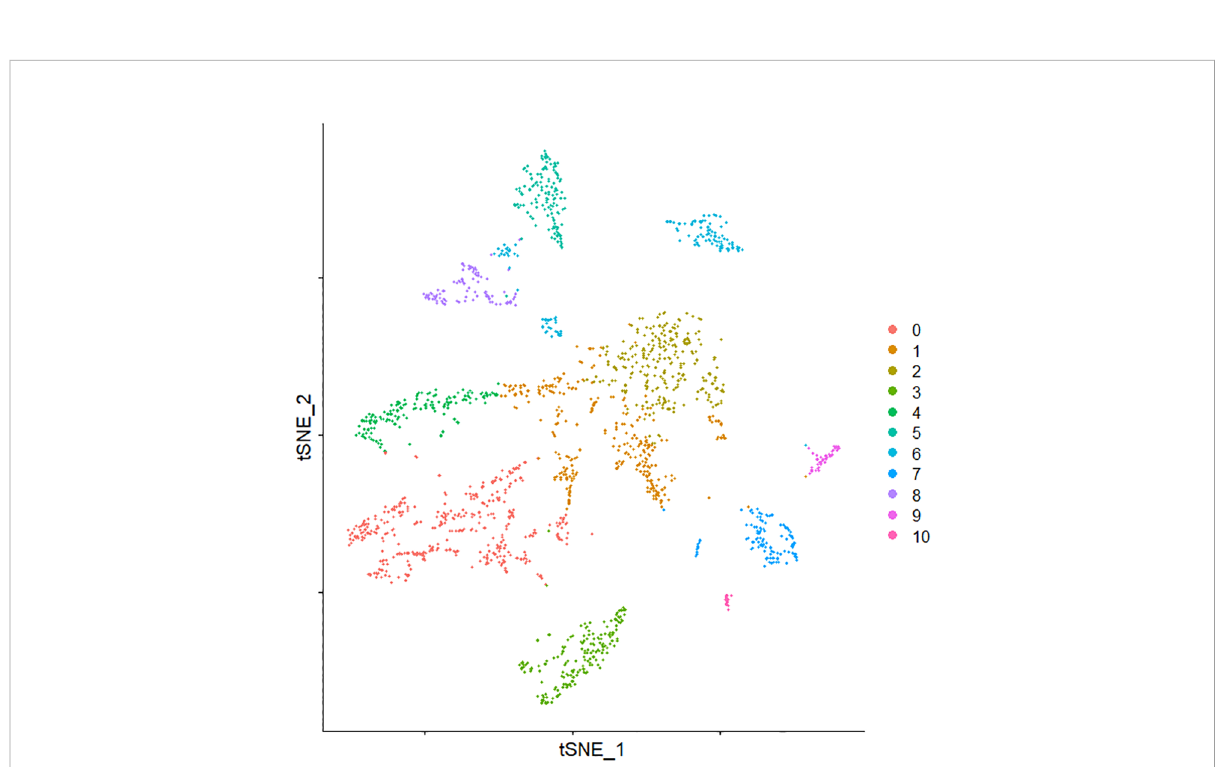
FIGURE 5 t-SNE of cell clustering result. t-SNE, t-distributed stochastic neighbor